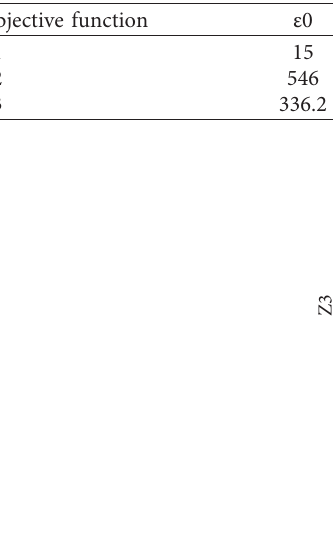
Table 18: Pareto solutions of objective functions. Additionally, Figure 4 draws a comparison of the values of objective functions Z1 and Z3 as an example to prove the conflict between the two objectives.